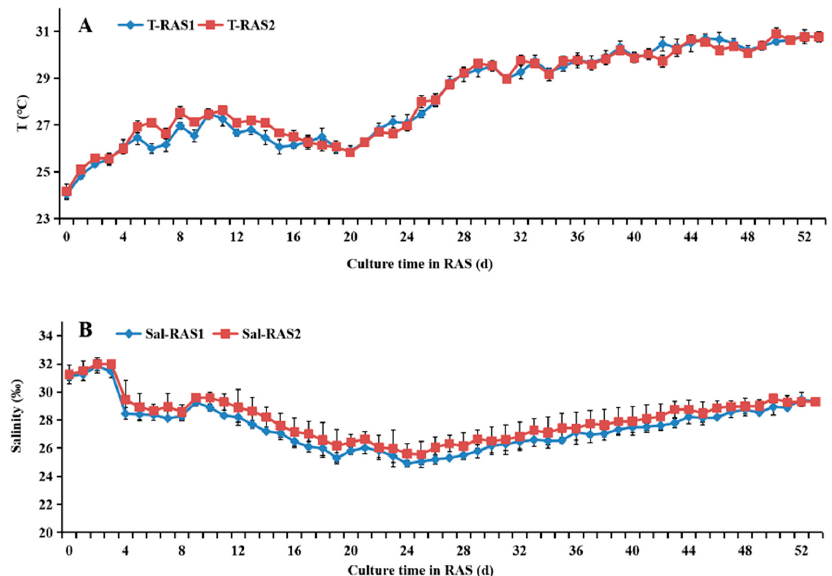
Figure 5. Changes in temperature ( A ) and salinity ( B ) in the culture tanks during the recirculating aquaculture period (means ± SE, n =3).